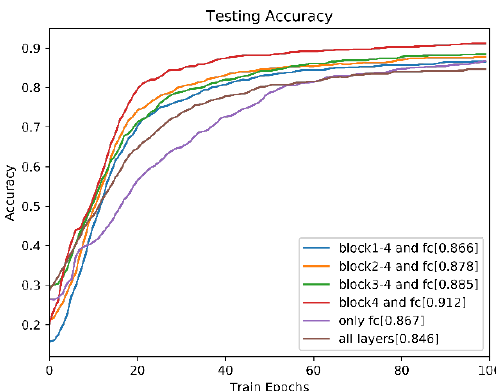
Figure 7. The first stage fine-tuning with different layers. When fine-tuning our network in the first stage, six situations were tested. The layers in the legend indicate that these layers were trained while the parameters of other layers were fixed during fine-tuning. Fine-tuning only block4 and fc achieves best classification results.